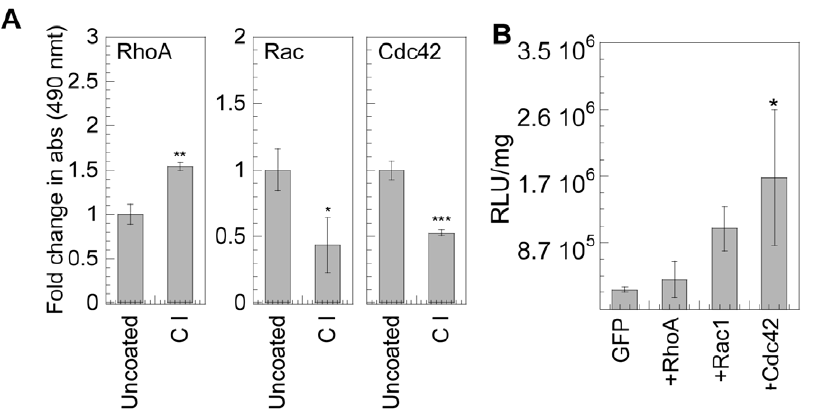
Figure 6. Effect of expression of constitutively active mutants of RhoGTPases on gene transfer for cells cultured on collagen I substrates. ( A ) mMSCs were cultured on amine functionalized PDMS strips and serum starved overnight before exposing to collagen I coated surfaces for 20 minutes to assess Rho-GTP and 1 hour to assess Rac and Cdc42-GTPases. The cells were subsequently lysed and respective GLISA assays were performed to quantify RhoA, Rac1,2,3 and Cdc42. Statistical analysis was done using the unpaired t-test (two tail p value). ( B ) mMSCs transiently transfected with constitutively active negative of RhoA, Rac1 or Cdc42 conjugated with GFP were cultured on collagen I coated plates for 16 hours prior to bolus transfection with polyplexes. The transgene expression was analyzed 48 hours post transfection using luciferase assay and normalized with total protein analyzed using Peirce BCA assay. Statistical analysis was done using a one-way Anova followed by the Dunnett Multiple Comparison test. The Anova p value was 0.0203. The symbols *, ** and *** represents a significant change to the level of p , 0.05, p , 0.01 and p , 0.001, respectively.